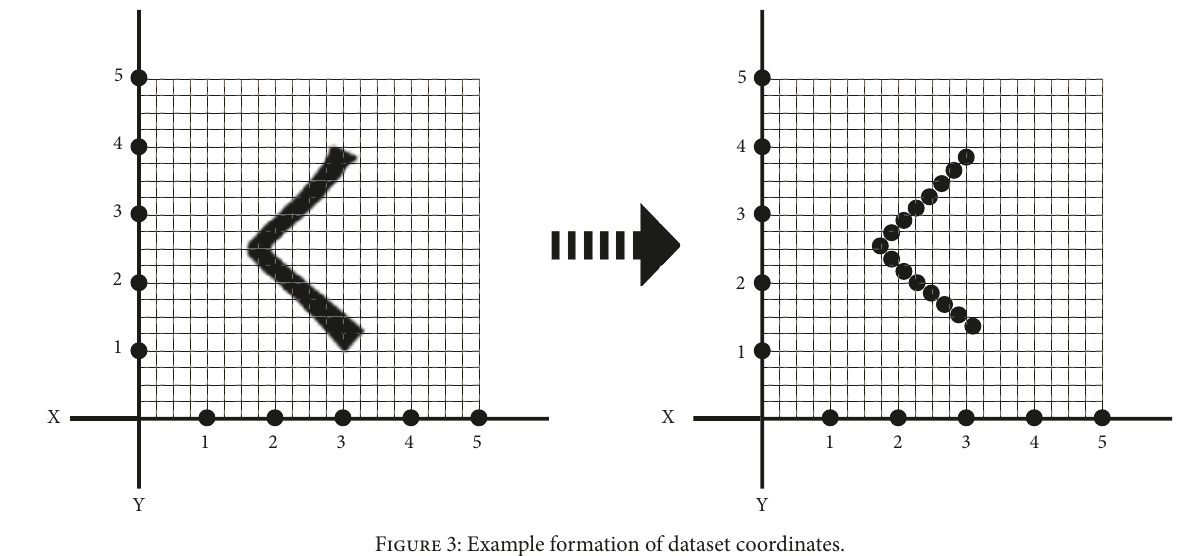
Figure 3: Example formation of dataset coordinates.